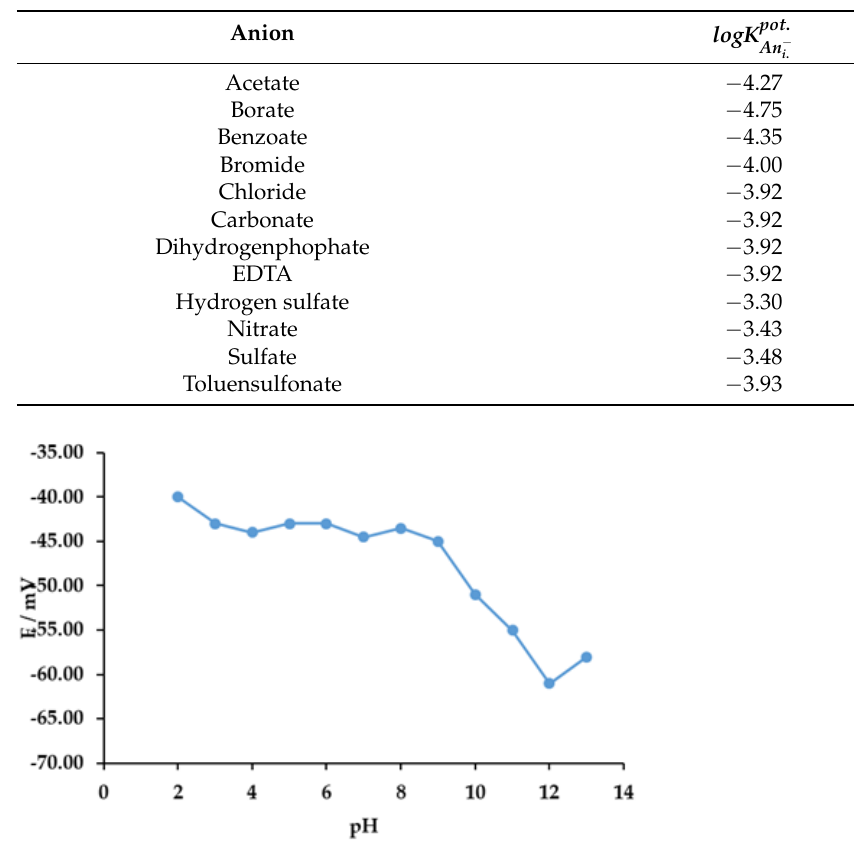
sodium salts (10 mM) for SDS response with the DODI–TPB surfactant sensor for SDS.